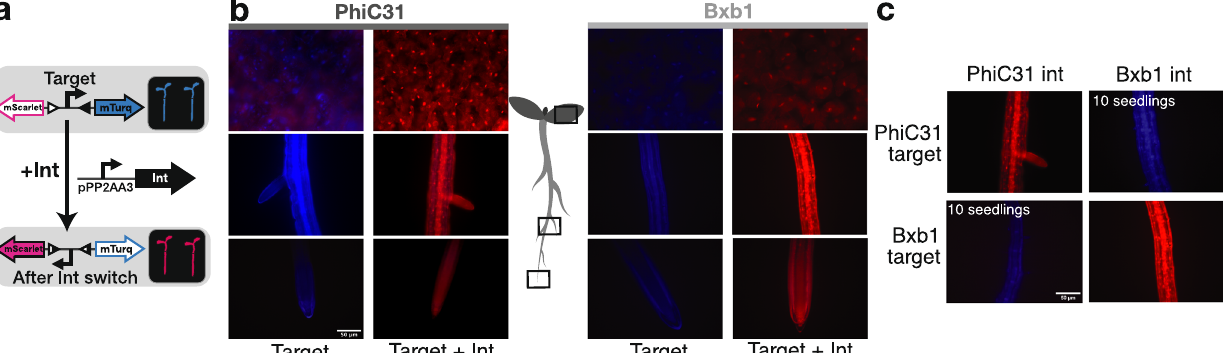
Fig. 1 | Integrase mediates orthogonal DNA-switch in Arabidopsis . a Design of the integrase target. The target is composed of two integrase sites (triangles) sur- rounding a constitutive promoter (pUBQ10) and two fl uorescent reporters (mTurquoise2andmScarlet).Inabsenceofintegrase,mTurquoise2isexpressed.In presence of integrase, the integrase mediates inversion of the DNA between the integrase sites, inverting the promoter, and leading to mScarlet expression. The expression of the integrase is mediated by the constitutive promoter pPP2AA3. b Constitutive integrase switch characterization. On the left side, Arabidopsis seedlings with PhiC31 target alone and PhiC31 target with pPP2AA3:PhiC31